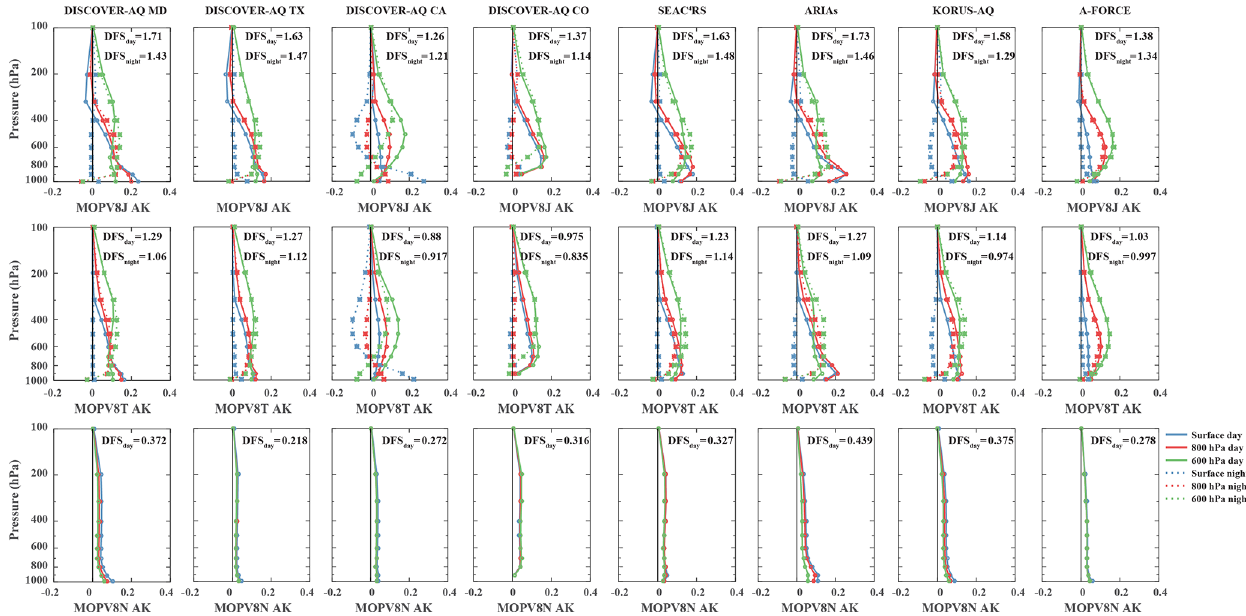
Figure 3. Mean retrieval averaging kernels for the MOPITT V8J, V8T, and V8N for the corresponding in situ profiles from the DISCOVER- AQ, SEAC 4 RS, ARIAs, KORUS-AQ, and A-FORCE at daytime (solid lines) and nighttime (dashed lines).